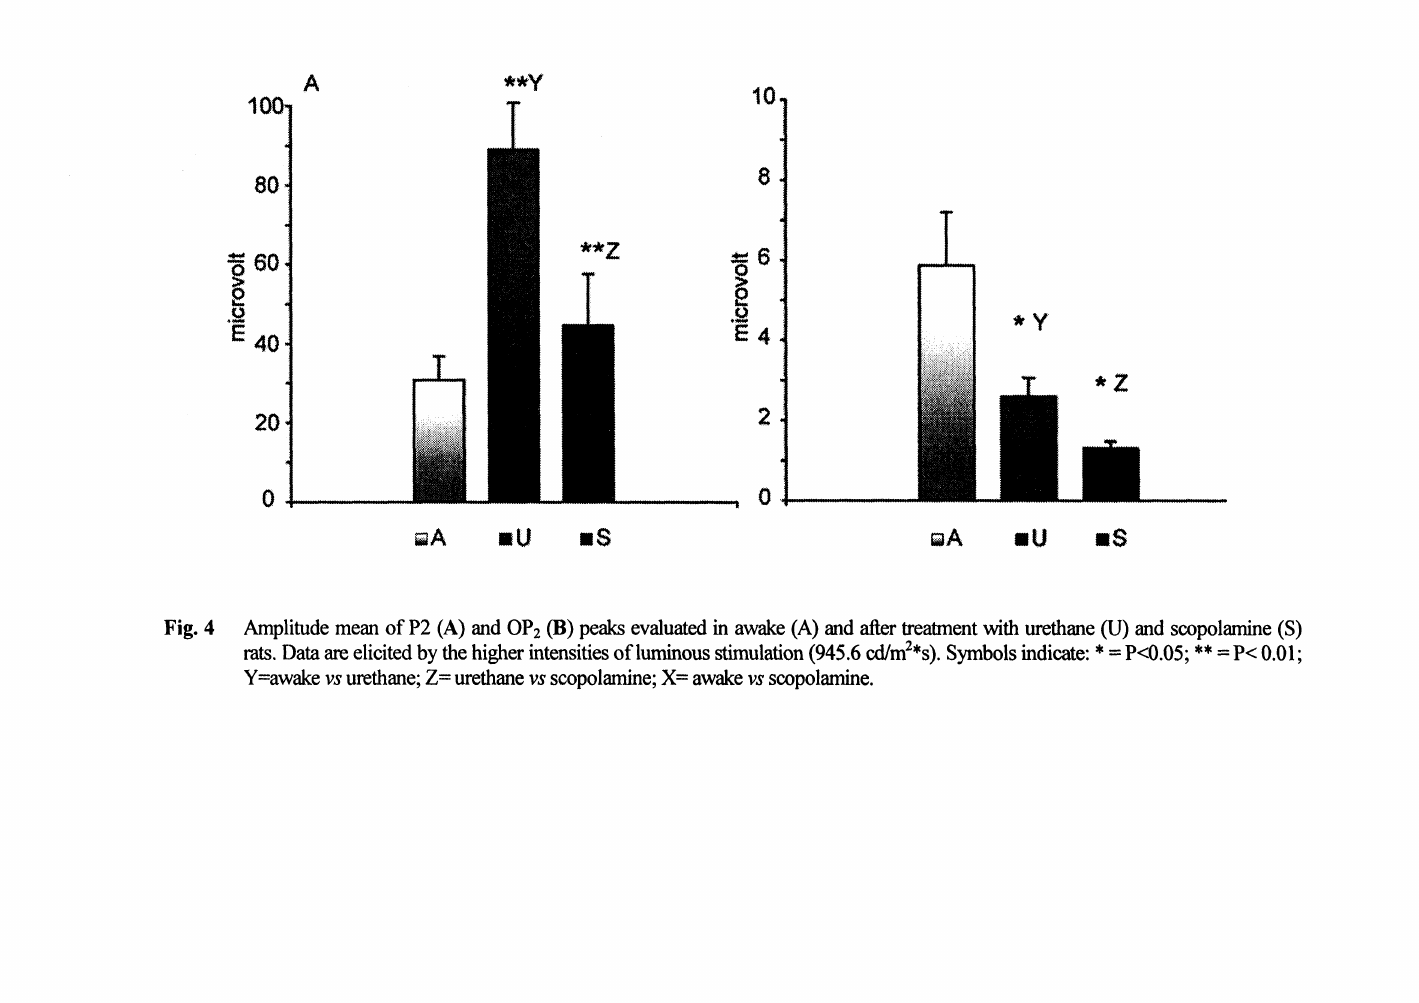
Fig. 4 Amplitude mean of P2 (A) and OP2 (B) peaks evaluated in awake (A) and after treatment with urethane (U) and scopolamine (S) rats. Data are elicited by the higher intensities of luminous stimulation (945.6 cd/m2*s). Symbols indicate: * P<0.05; ** P< 0.01; Y=awake vs urethane; Z urethane vs scopolamine; X awake vs